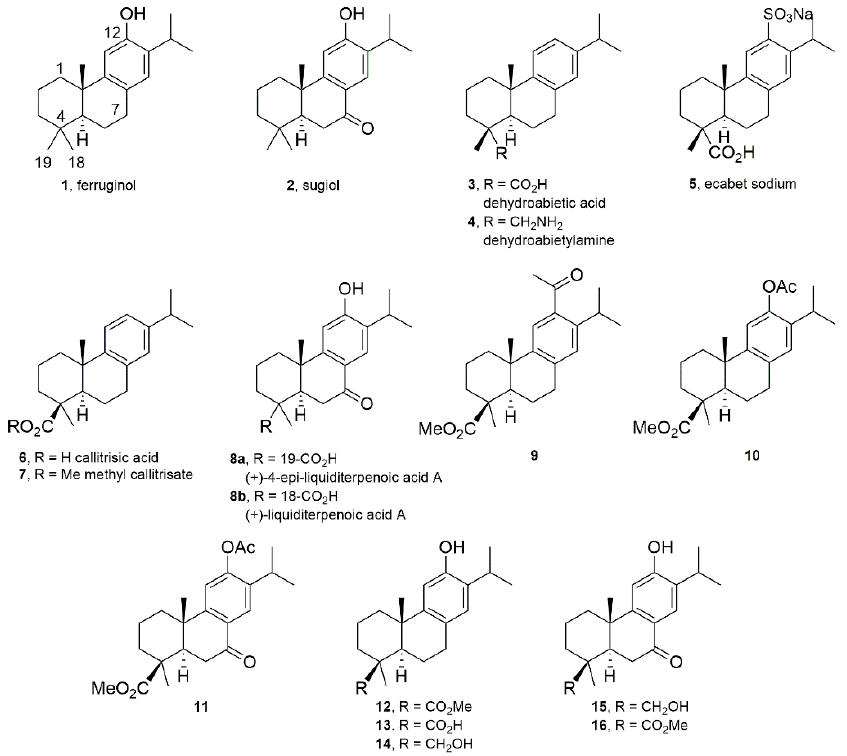
Figure 1. Examples of bioactive abietane diterpenoids 1–7 and tested molecules 8a , and 9–16. Dehydroabietic acid (3) displays antileishmanial activity in both promastigotes and amastigotes of Leishmania amazonensis [12]. Previously, Moreira and coworkers reported on the antileishmanial activities of dehydroabietic acid derivatives and dehydroabietylamine amides, which were capable of killing Leishmania donovani amastigotes [13,14]. Ferruginol (1) has also shown promising antileishmanial activity against L. donovani promastigotes [15]. In addition, dehydroabietic acid (3) from Boswellia thurifera resin has been reported as a positive gamma-aminobutyric acid type A (GABA A ) receptor modulator [16]. Recently, we reported on the synthesis and biological activity of (+)-liquiditerpenoic acid A or abietopinoic acid [17]. In that work, we synthesized and studied biologically (antitumor, GABA A modulation and antileishmanial) a series of ferruginol analogs functionalized at C-18 from (–)-abietic acid via methyl dehydroabietate (C-4 epimeric compounds of those depicted in Scheme 1). Despite the important pharmacological properties of abietane diterpenoids, there is only one commercial drug, ecabet, composed of abietane-derived diterpenoids (ecabet sodium (5) (Figure 1) for the treatment of reflux esophagitis and peptic ulcer disease). Thus, this family of natural products offers ample opportunity for further studies due to their promising biological activities. In continuation of our